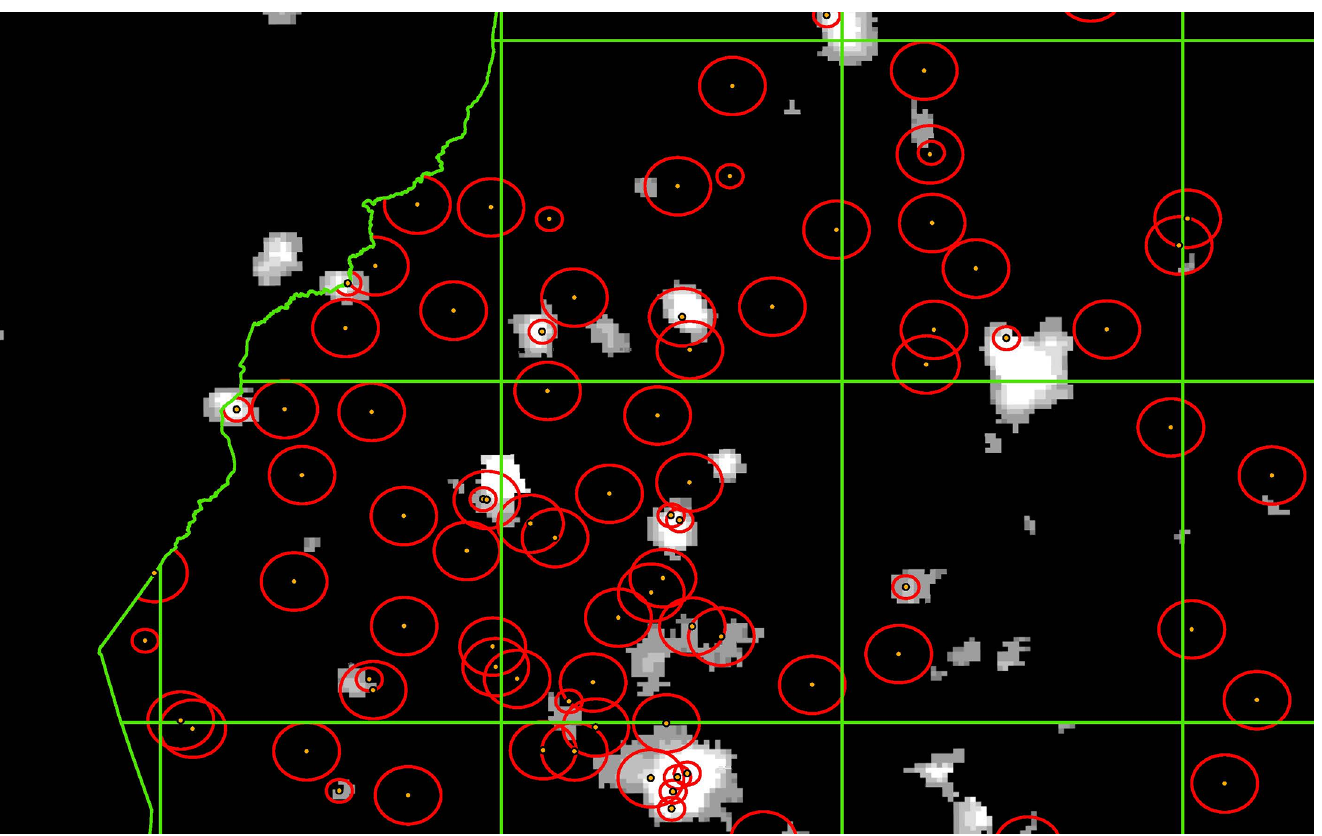
Fig 1. Illustration of DHS clusters, nighttime lights and our spatial units for Western Kenya. Dots represent reported DHS cluster center points from Kenya DHS 2008. Circular zones around these center points (in red) have a 2 km radius for urban clusters and a 5 km radius for rural clusters. The grid cells of 0.5 × 0.5 decimal degrees (in green) are aligned to the PRIO-GRID. Nighttime lights underlay the map, with brighter tones of grey implying more intense nighttime lights.